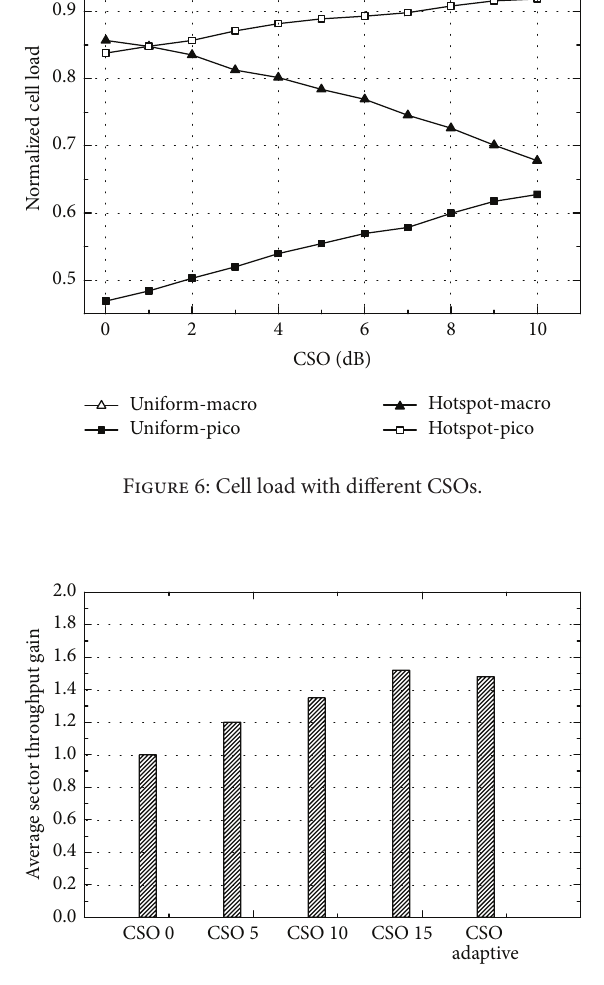
Figure 7: Average sector throughput gain in uniform scenario.